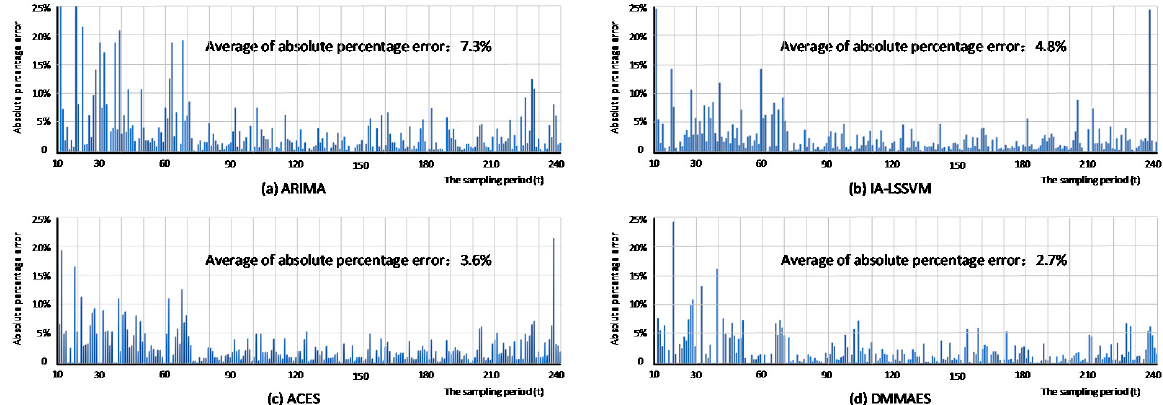
Figure 11. Histogram of the absolute percentage error of traffic volume prediction results.